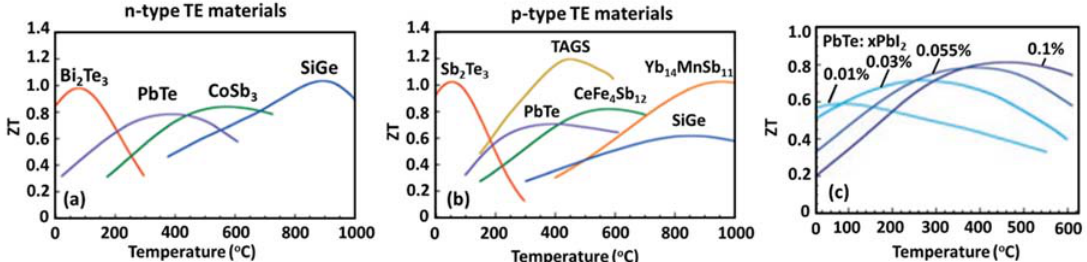
Figure 7. Some of the widely used TE materials with their operating temperature and figure-of-merit, ZT. ( a ) n-type TE materials; ( b ) p-type TE materials. Most of the TE materials shown here are complex alloys with dopants and compositions approximated; ( c ) Variation in peak ZT and the optimal temperature with change in dopant concentration for n-type PbTe. Changing the dopant concentration not only alters the peak ZT but also the optimal temperature where the peak occurs. Adapted from [33], with permission from © 2008 Springer Nature.